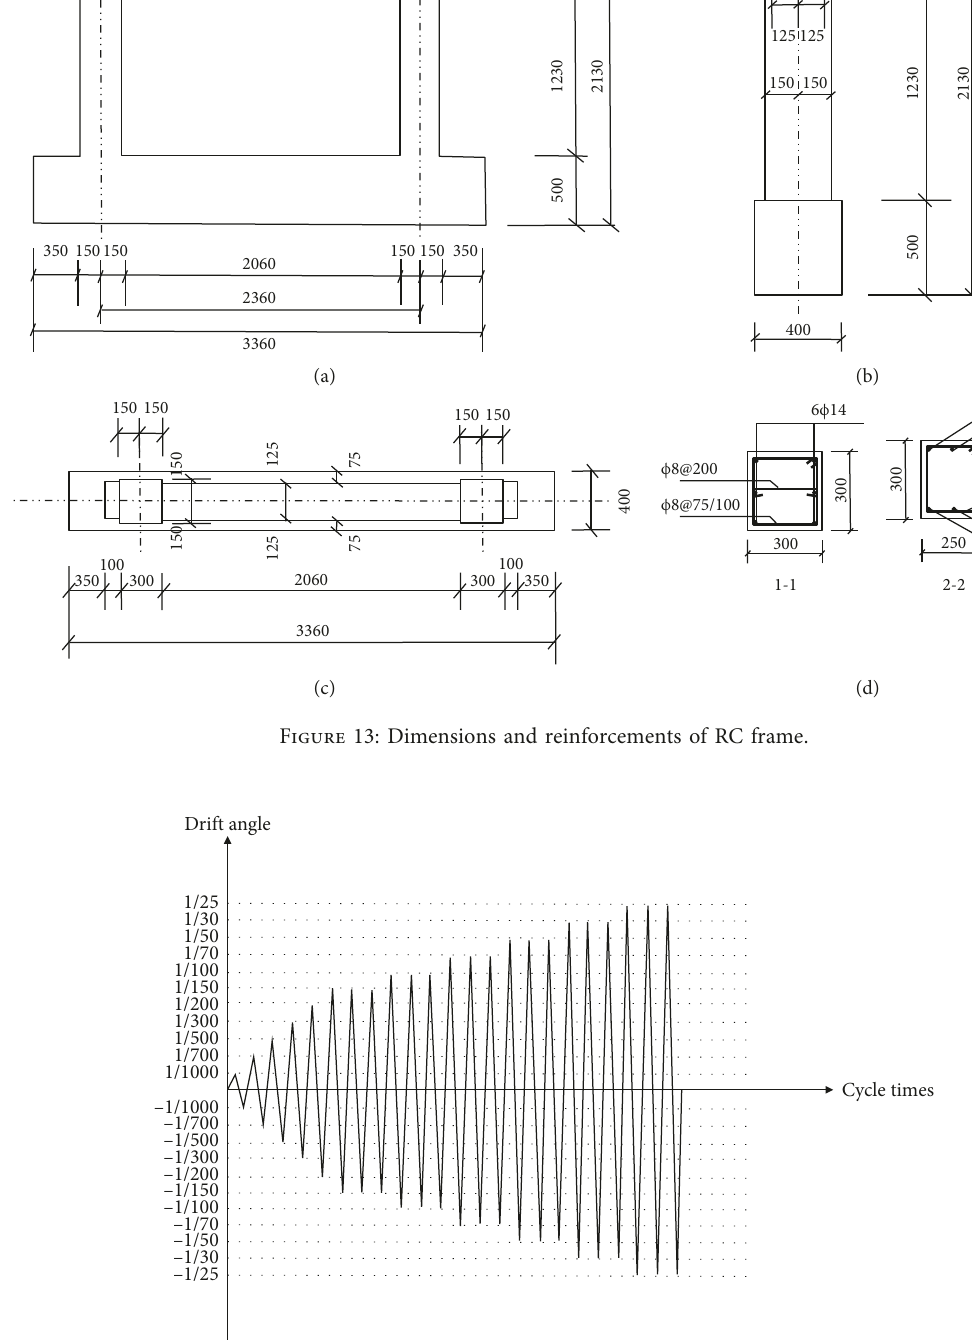
Figure 14: Lateral loading